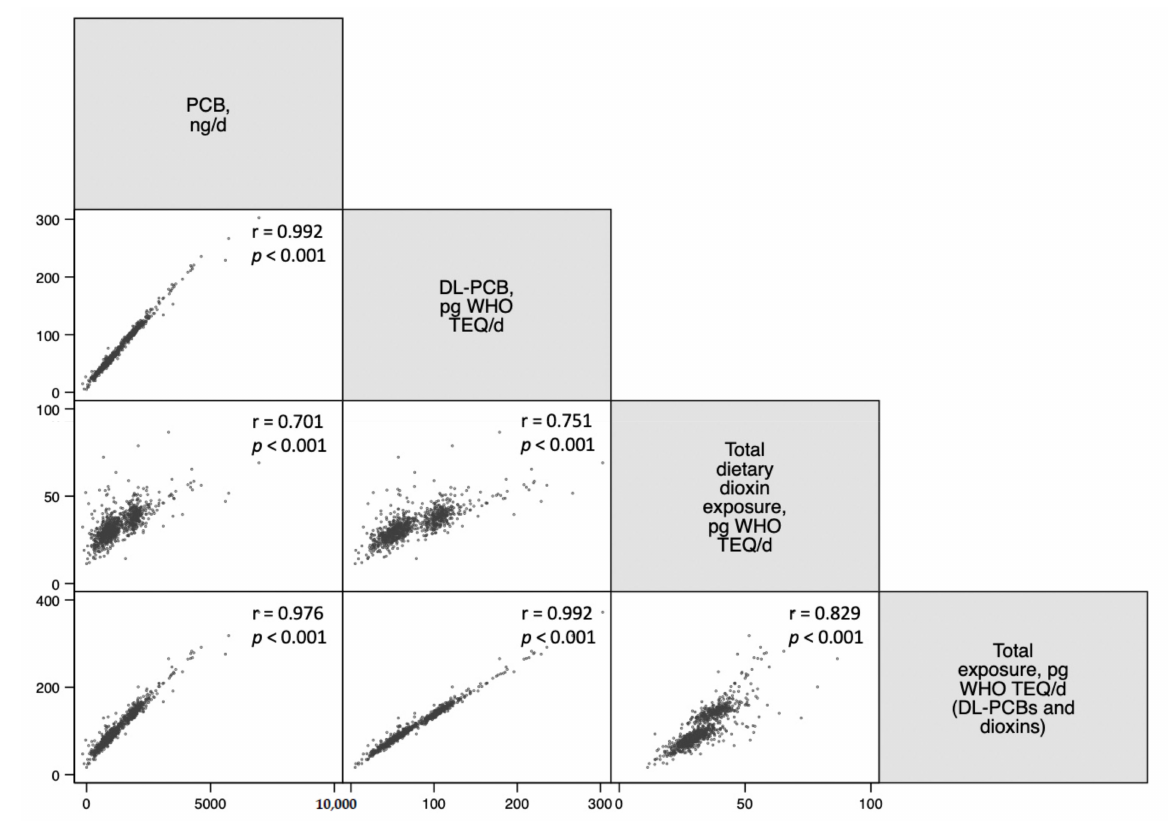
Figure 2. Spearman correlation analysis between dietary exposure to PCBs and dioxins energy- adjusted intake. Abbreviations: DL-PCBs; Dioxin-like polychlorinated biphenyls; PCBs, polychlori- nated biphenyls; SUN, Seguimiento Universidad de Navarra; TEQ, Toxic Equivalents; WHO, World Health